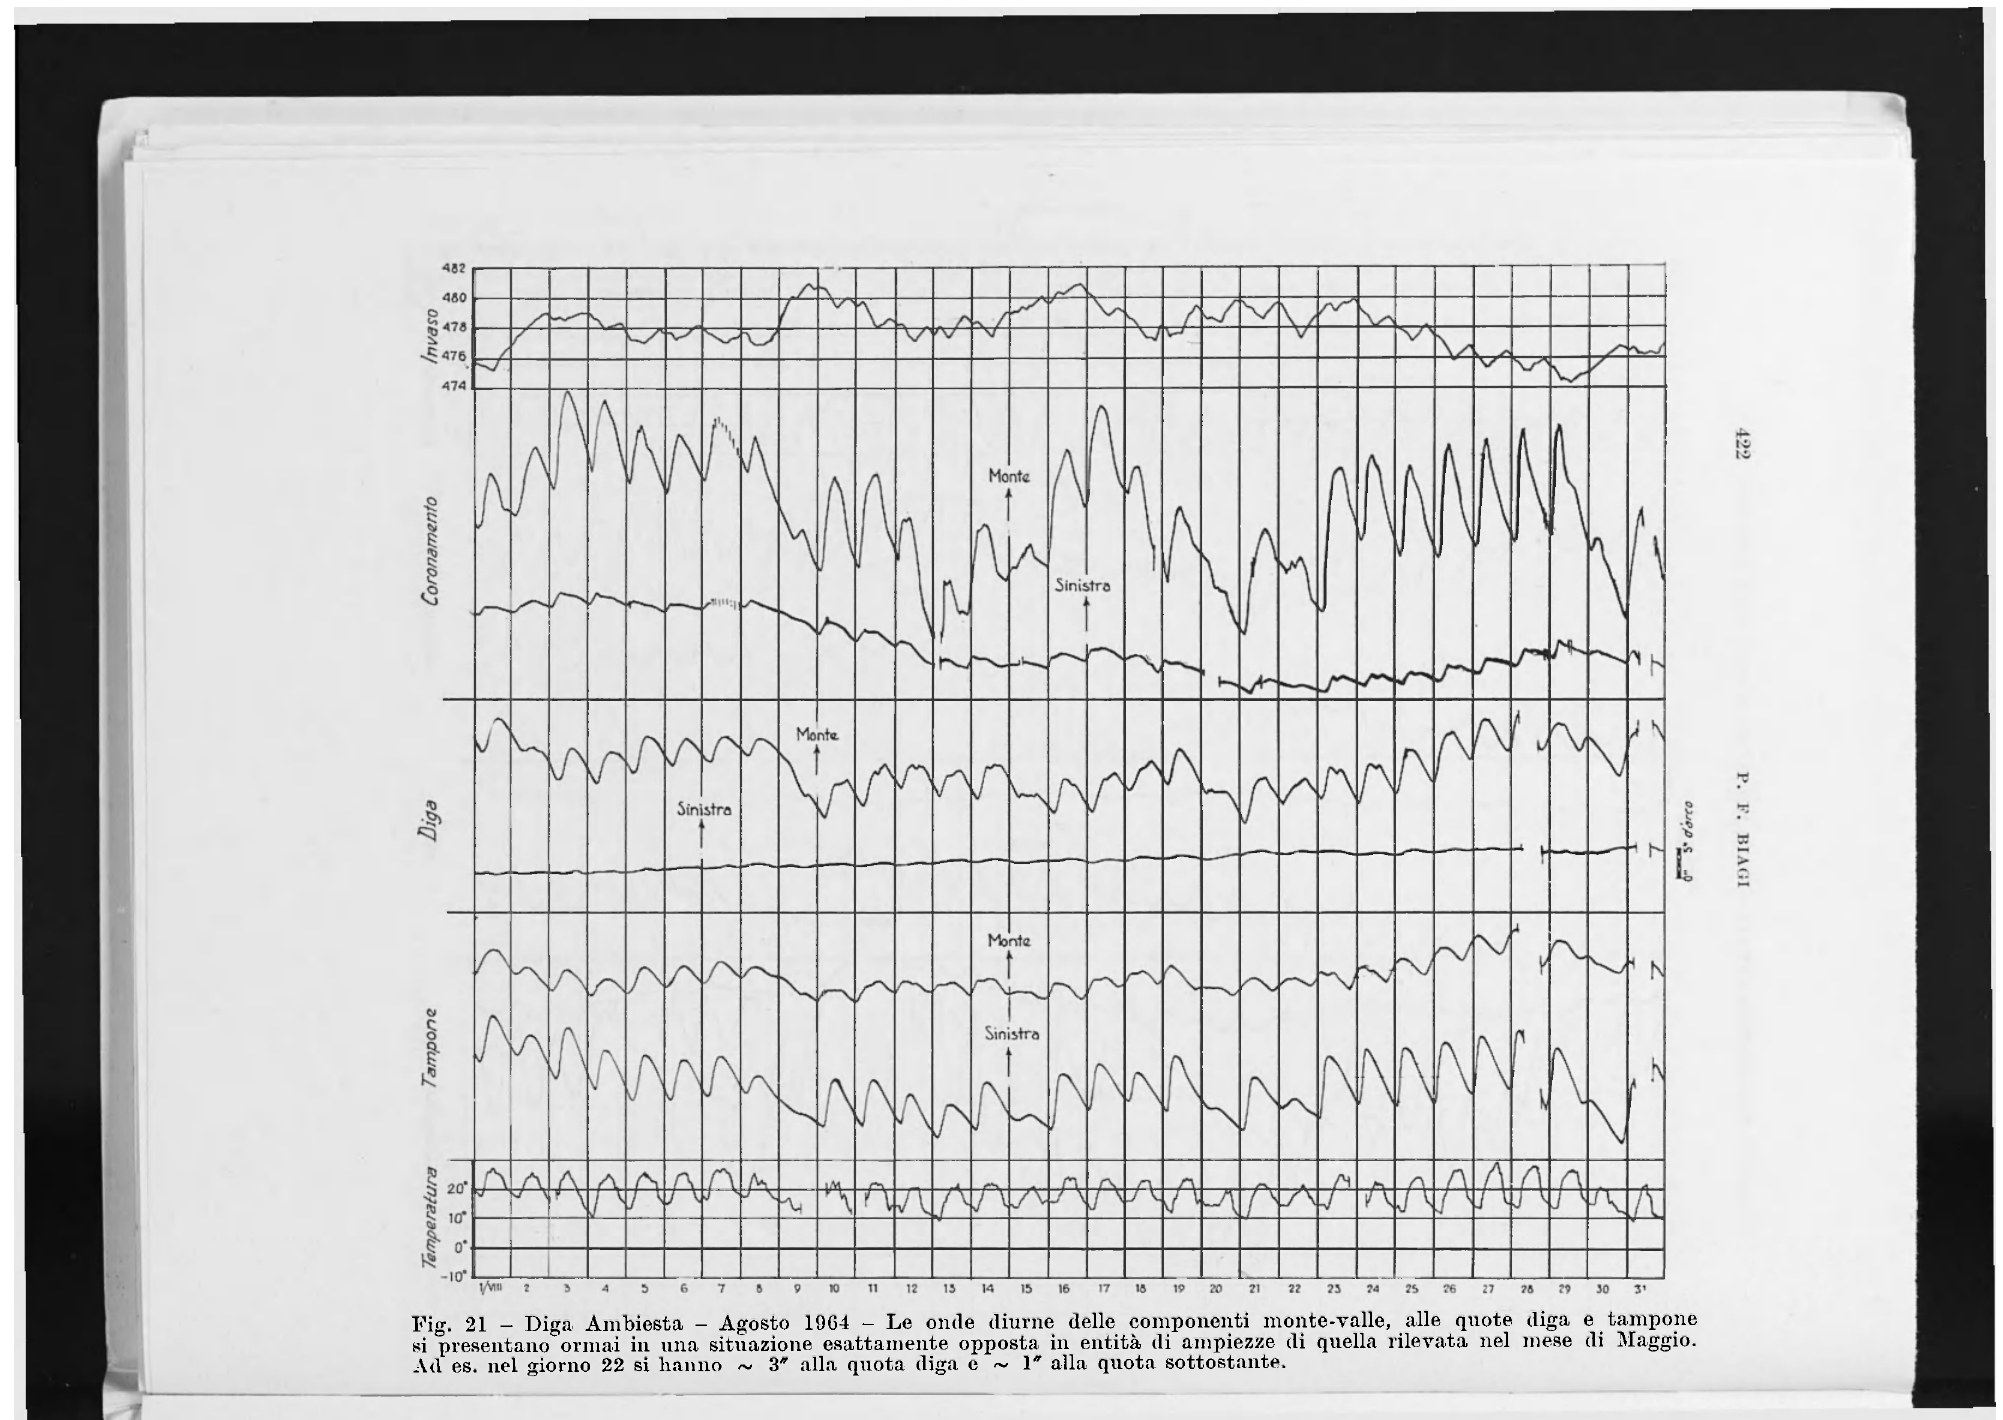
Fig. 21 - Diga Ambiesta - Agosto 1964 - Le onde diurne delle componenti monte-valle, alle quote diga e tampone si presentano ormai in una situazione esattamente opposta in entità di ampiezze di quella rilevata nel mese di